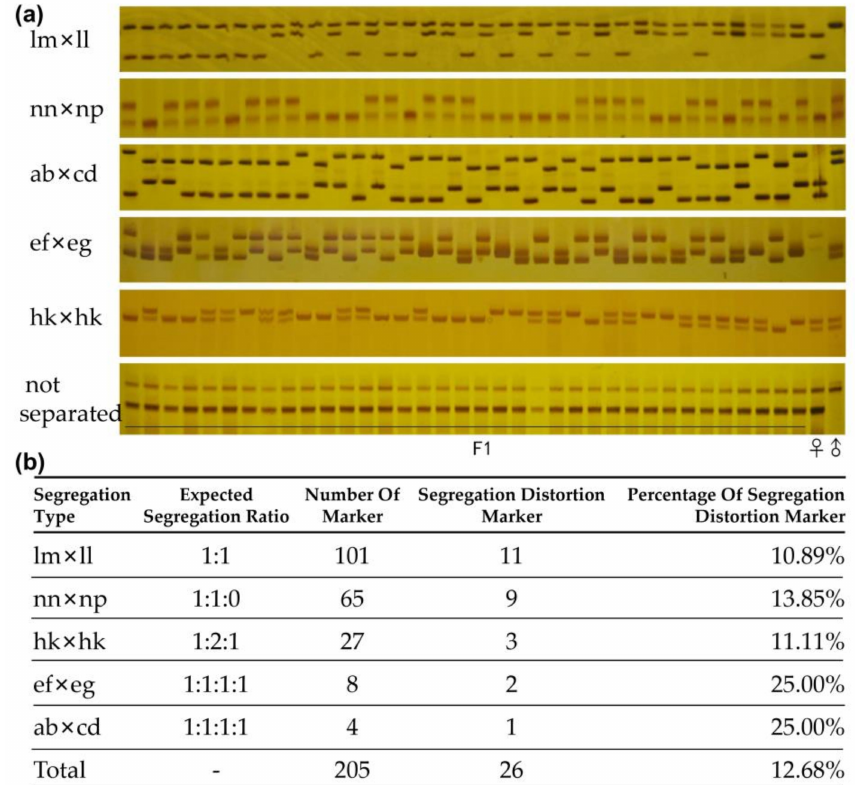
Figure 3. Screening and verification of SSR and InDel markers. ( a ) Five types of segregation and one type of null amplification for 36 hybrid progenies from the F1 hybrid population. ( b ) Summary of the segregation types and distorted segregation